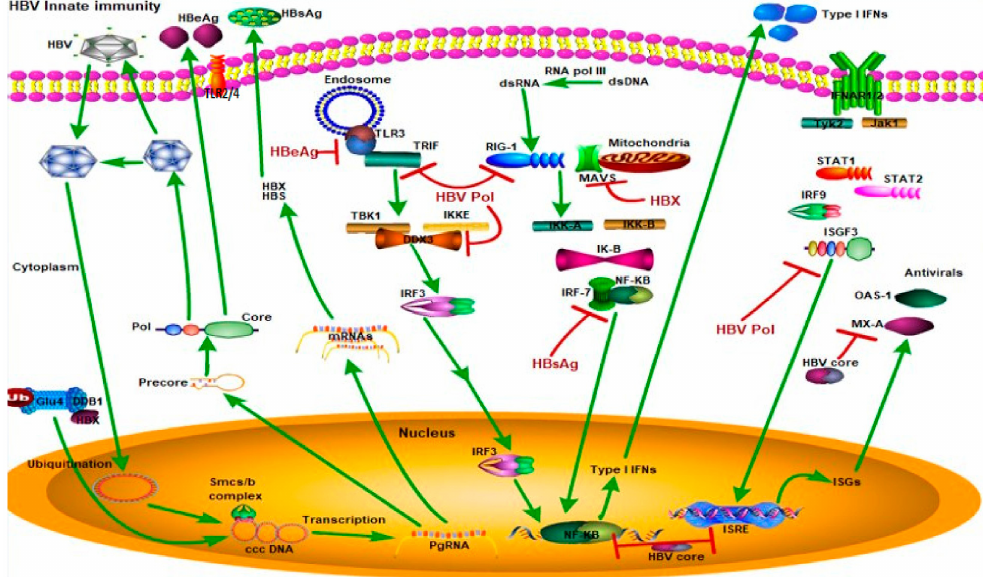
Figure 3. HBV suppression of type I interferon (IFN) response (Green arrows indicate the related signaling pathways and T-arrows in red indicate blocking the targets). Di ff erent HBV proteins block the type I IFN response. For example, hepatitis B surface antigen (HBsAg) inhibits interferon